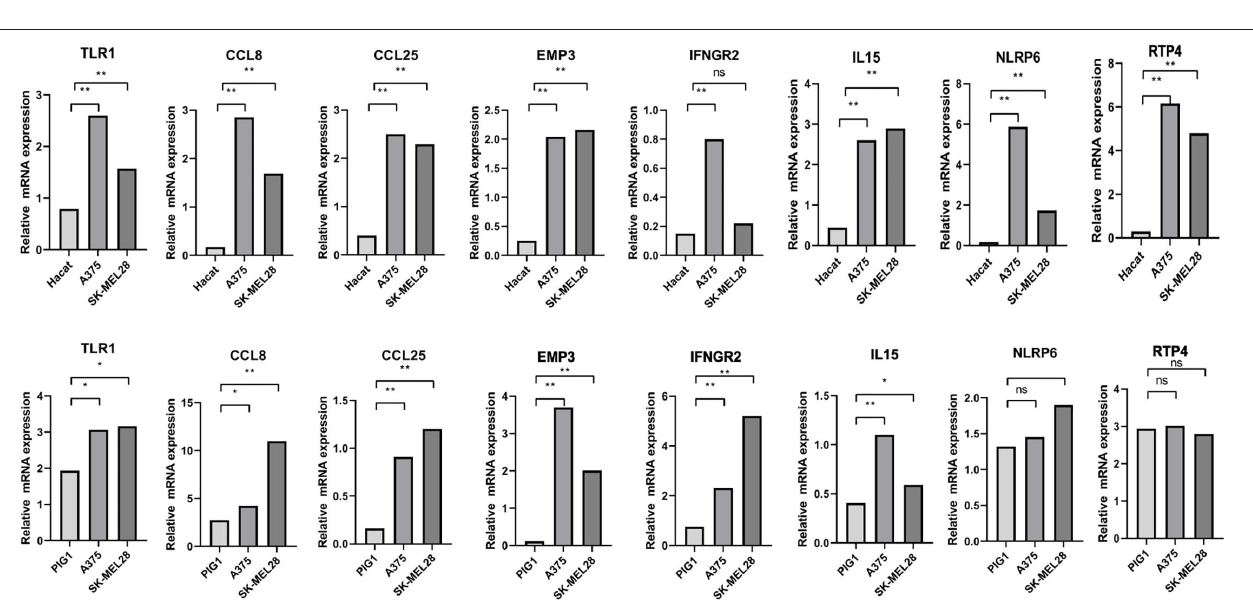
FIGURE 11 | Validation of the expression of GRIPs in qRT-PCR. ns, not significant; * p < 0.05; ** p <